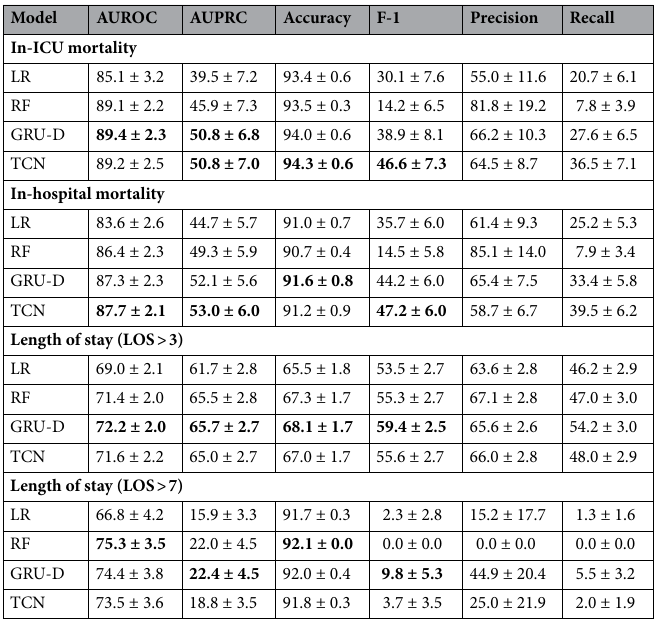
Table 2. Hold-out validation performance of all models in all binary classification tasks (value ± 95% CI). All values shown in %. Primary evaluation metrics: AUROC, AUPRC, Accuracy, F-1. Secondary evaluation metrics: precision, recall. TCN, temporal convolution network; GRU-D, gated recurrent unit with delay; RF, random forest; LR, logistic regression; AUROC, area under receiver operating curve; AUPRC, area under precision recall curve. Best-in-task values for primary evaluation metrics are in